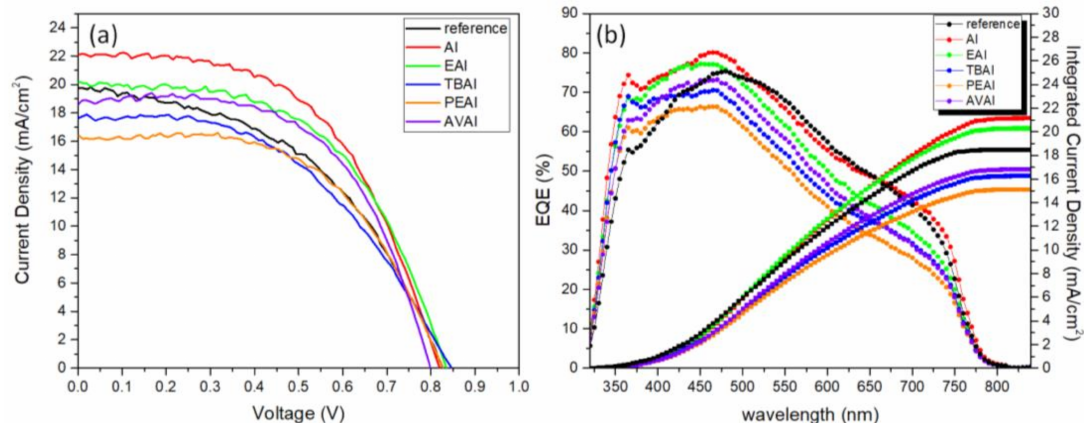
Figure 12. ( a ) Current density–voltage curves of the 6 carbon-based solar cells under study, under illumination of 100 mW cm − 2 simulated sun irradiation (1.5 AM) and ( b ) EQE of the corresponding solar